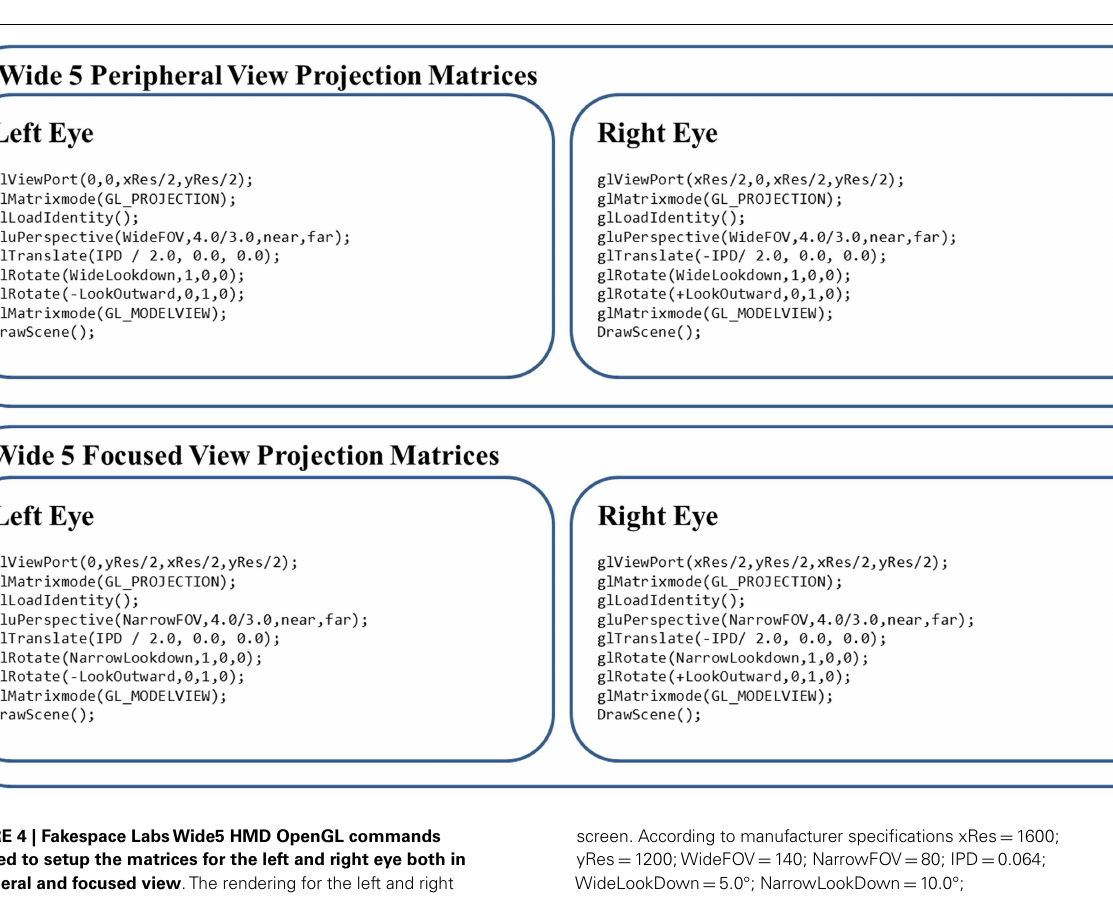
FIGURE 4 | Fakespace LabsWide5 HMD OpenGL commands required to setup the matrices for the left and right eye both in peripheral and focused view .The rendering for the left and right display of the peripheral view is performed on the top half of the screen while the focused view is rendered to the bottom half of the